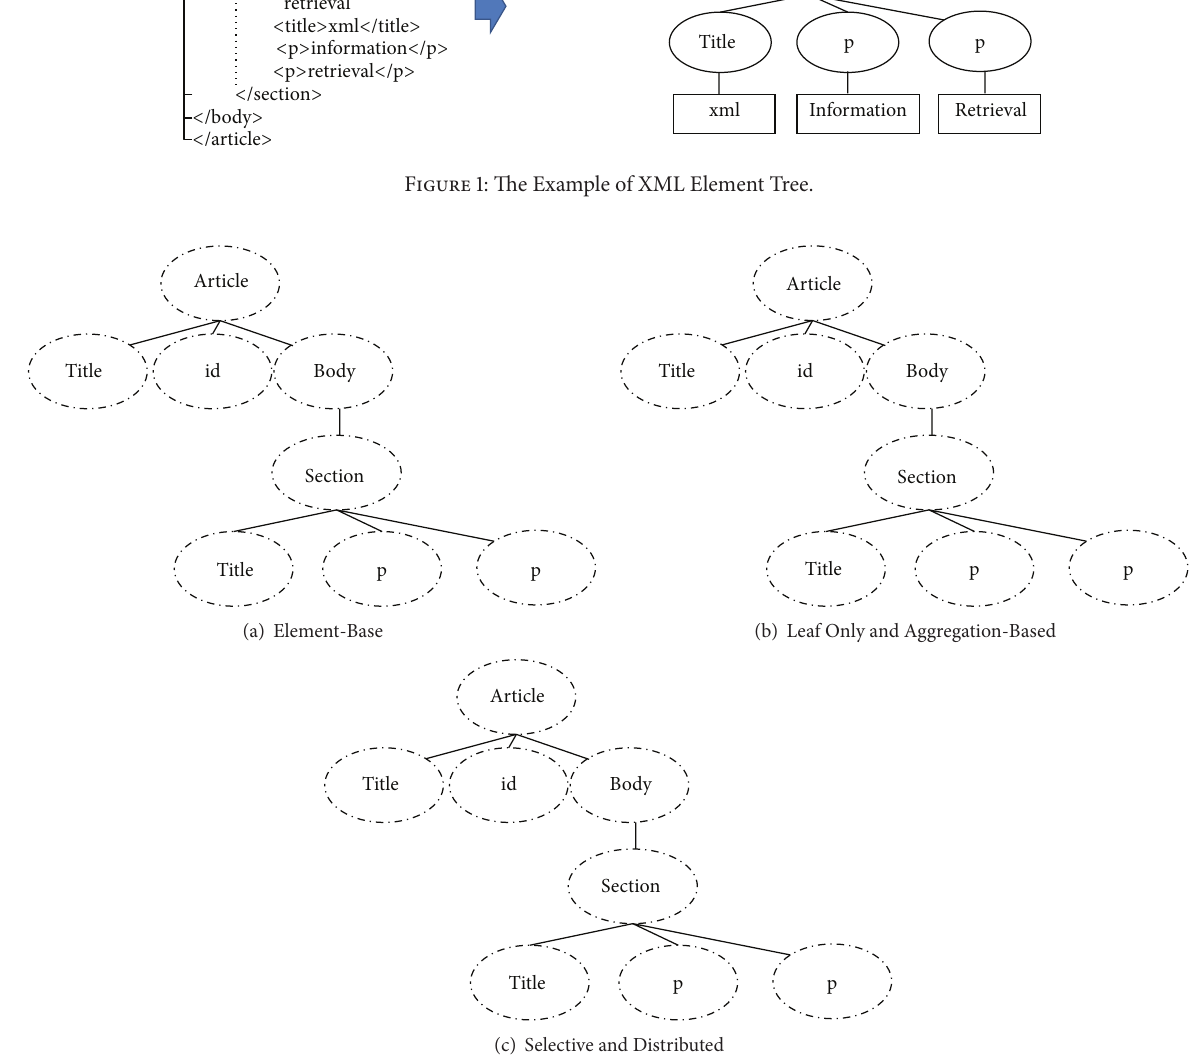
Figure 2: Illustrations of some of the indexing